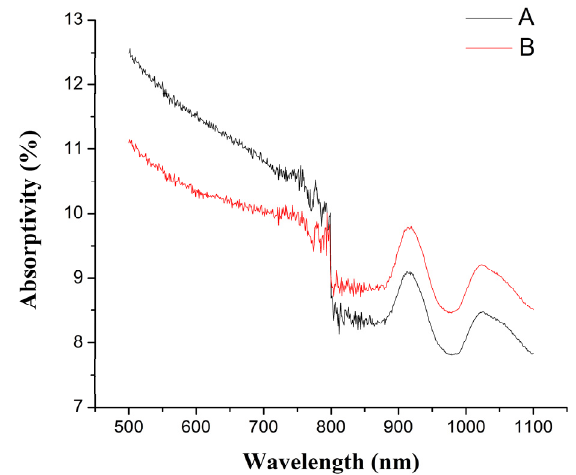
Figure 9. The absorptivity of PP at different wavelength before and after grafting